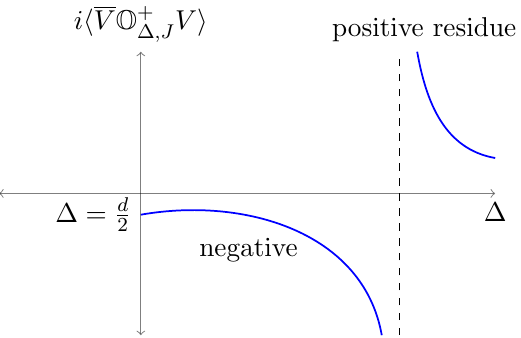
Figure 15. We show that i h V O +